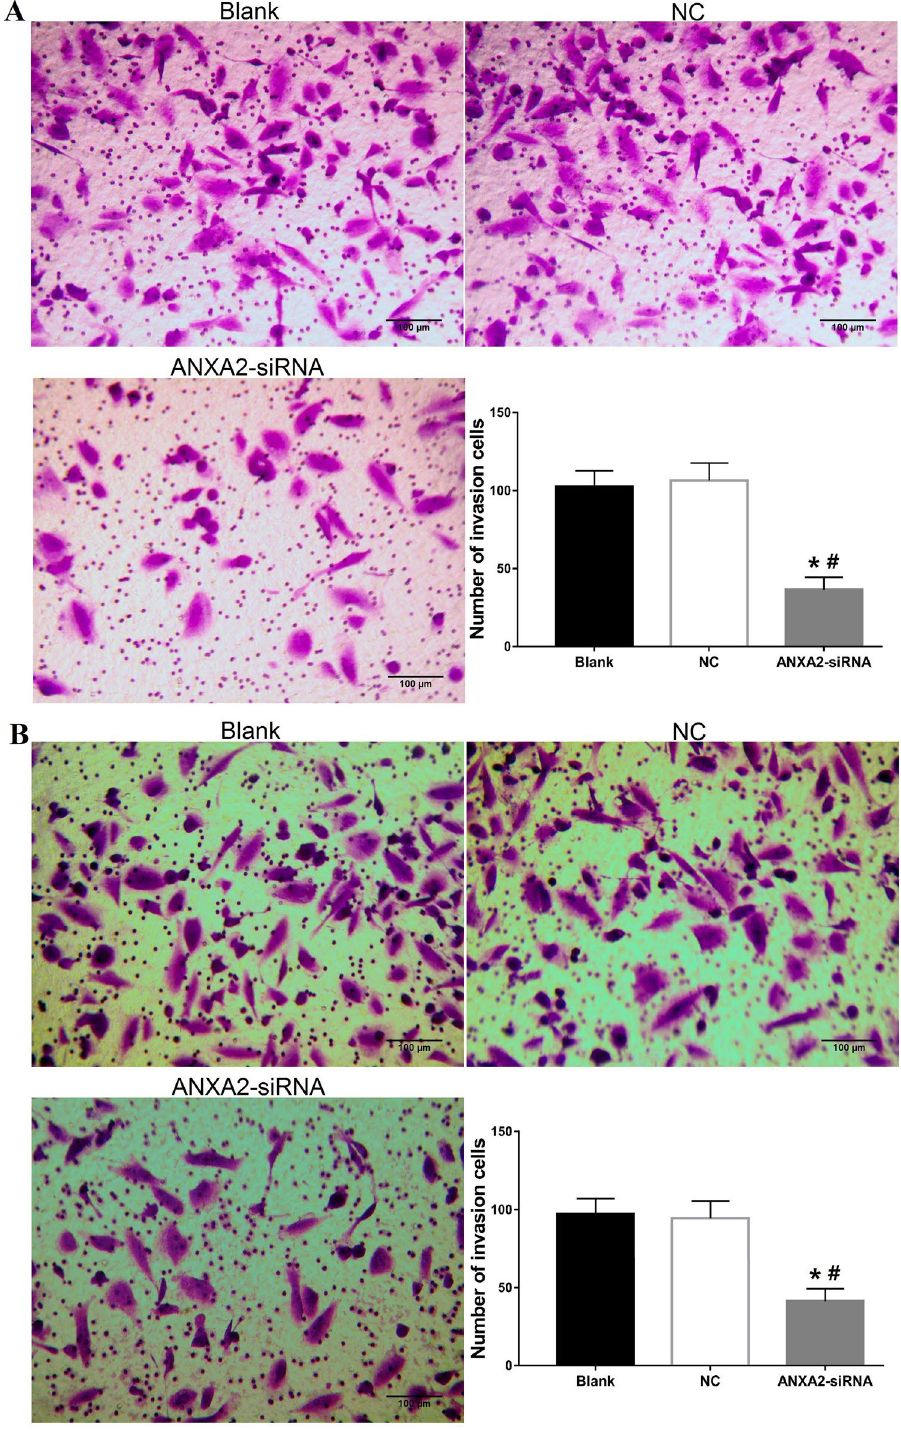
Figure 7. Effect of silencing ANXA2 expression on invasion ability of HSC-3 and SCC-4 cells measured by Transwell assay. ( A ) The invasion ability of HSC-3 cells in a visual field. ( B ) The invasion ability of SCC-4 cells in a visual field. Data were presented as the mean ± SD of five visual fields at least three repeated experiments. * P < 0.05, compared with blank group; # P < 0.05, compared with NC